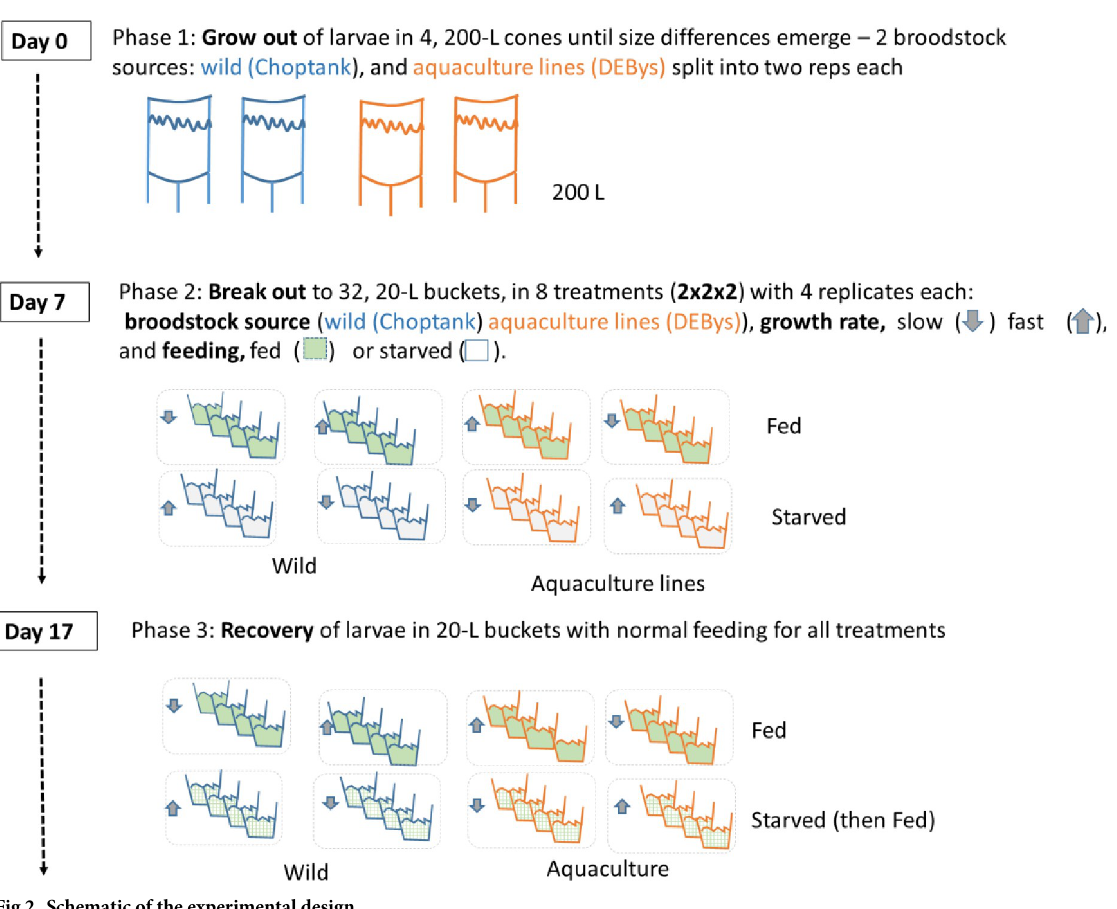
Fig 2. Schematic of the experimental